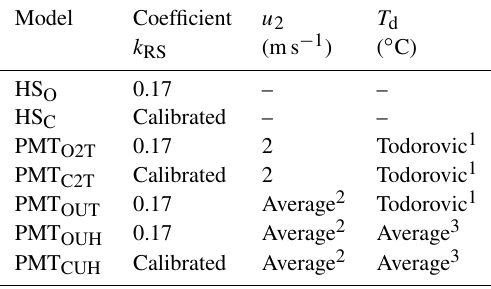
Table 2. Characteristics of the models used in this study.